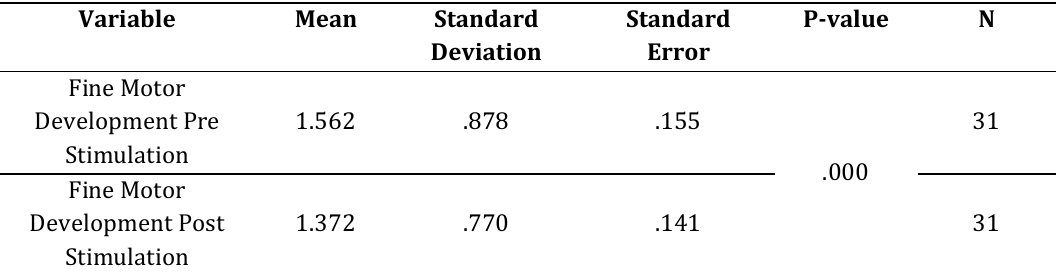
Effectiveness of the Use of Educational Game Tools Against Stimulation of Fine Motor